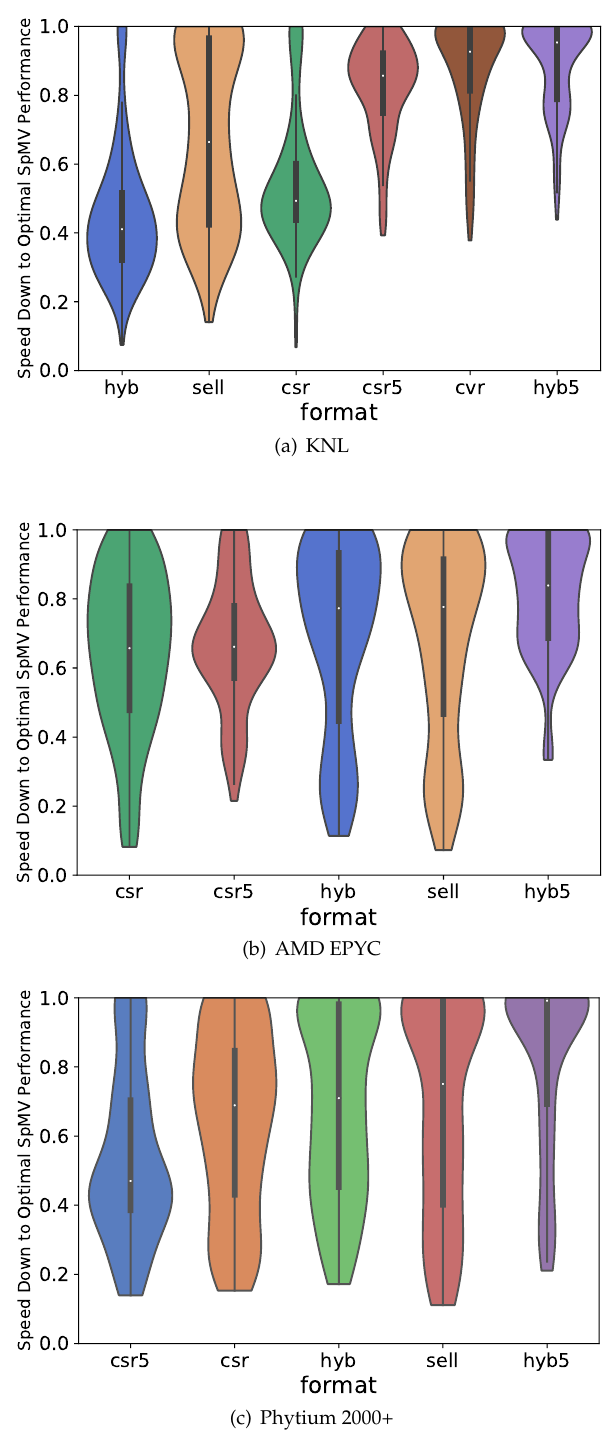
Figure 7. Comparing HYB5 performance to state-of-the-art formats. The violin diagrams show the reduction ratio of the compared formats for the relatively optimal format of SpMV performance for each matrix. The shape of the violin represents the distribution of the acceleration ratio over the data set, and the bold black line is the location of 50% of the data